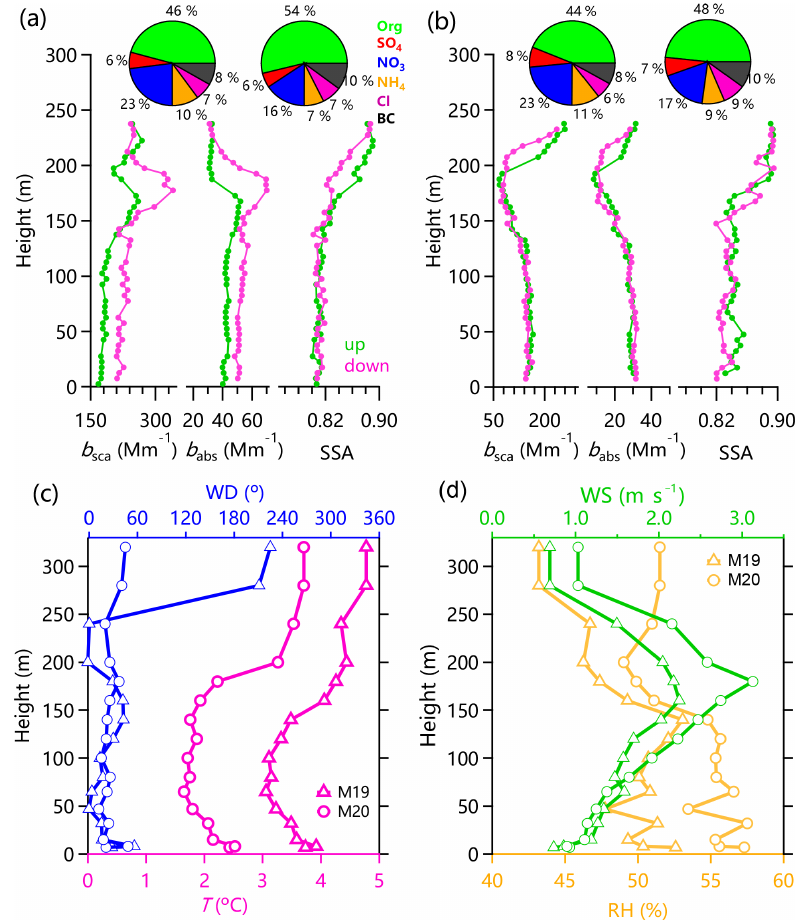
Figure 8. Vertical profiles of b sca , b abs , and SSA measured by PAX at 880nm during (a) M19 and (b) M20. Panels (c) and (d) show the average vertical profiles of T, RH, WS, and WD during M19 and M20, respectively. The pie charts show average chemical composition of